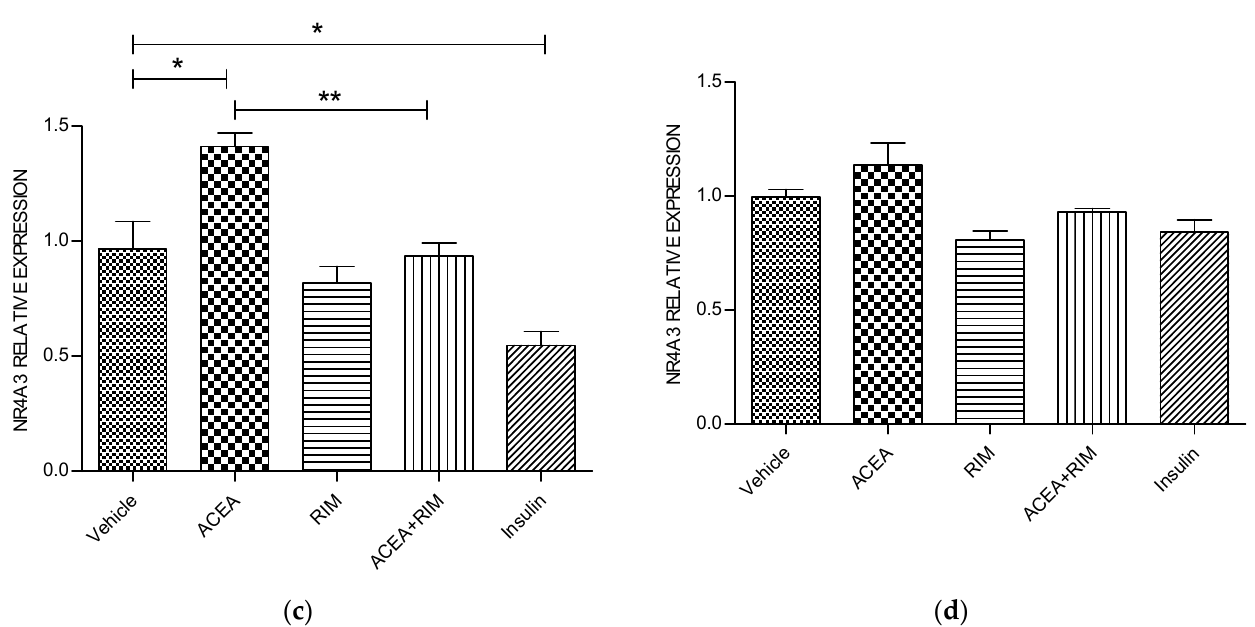
Figure 4. NR4A3 muscle myotubes—ACEA, rimonabant, ACEA and rimonabant, and insulin affect NR4A3 gene expression; myotubes fed with delipidated serum. The stimulation time covered 3 to 24 h, and NR4A3 mRNA levels, relative to TATA-Box, was evaluated by quantitative real-time PCR (qRT-PCR) (100 nM). The following scenarios explain the stimulation process conducted: ( a ) Stimulation was done for 1 h. ( b ) Stimulation was done for 3 h. ( c ) Stimulation was applied for up to 5 h. ( d ) Stimulation was applied for up to 24 h. The data were reported as the mean ± SEM of three separate groups. (n = 3; *denotes p < 0.05, and **denotes p < 0.01). Data were investigated by conducting one-way ANOVA test and Tukey test. NR4A3; nuclear receptor subfamily 4, group A, member 1.